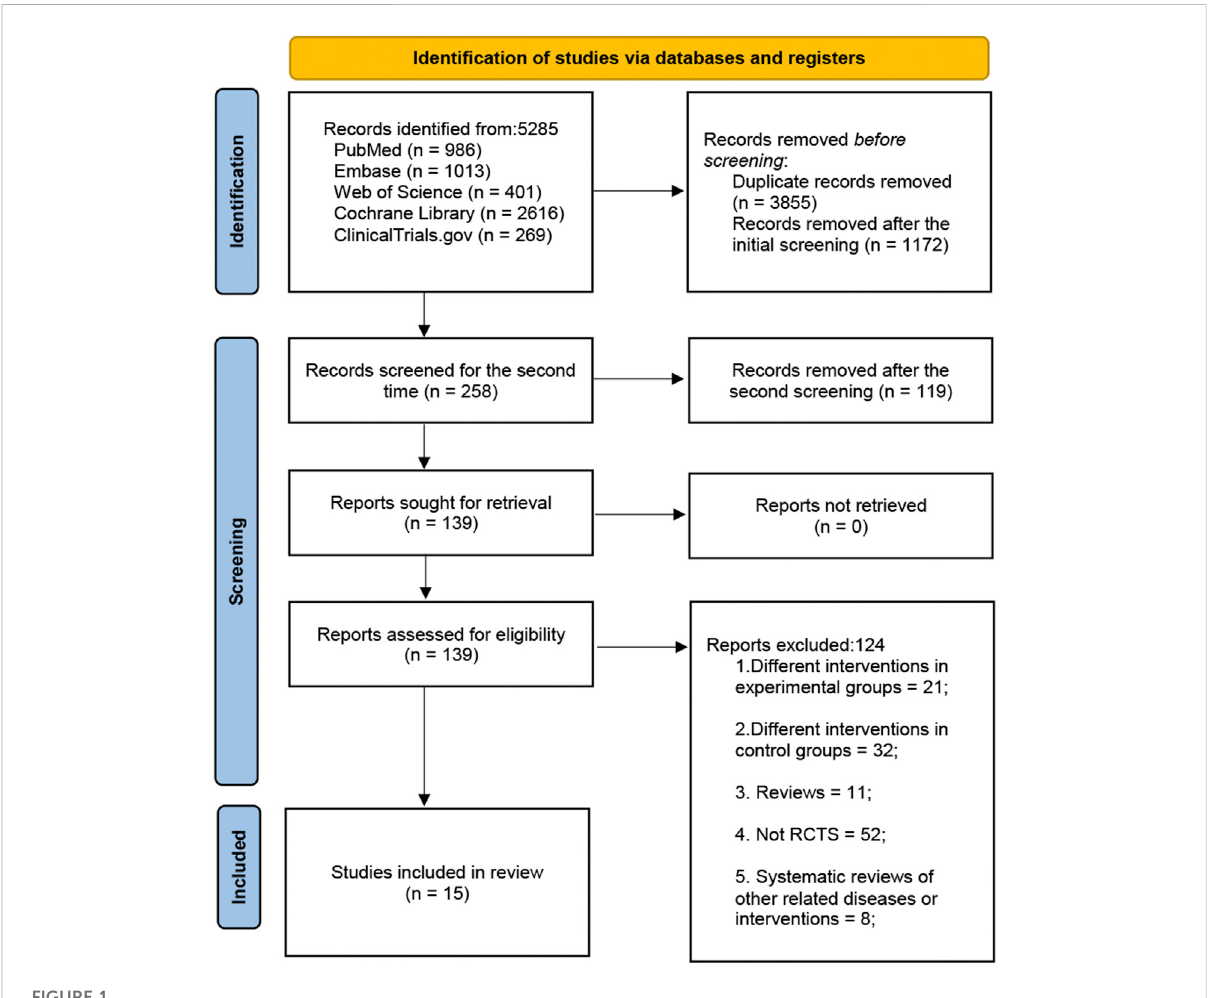
PRISMA fl owchart for